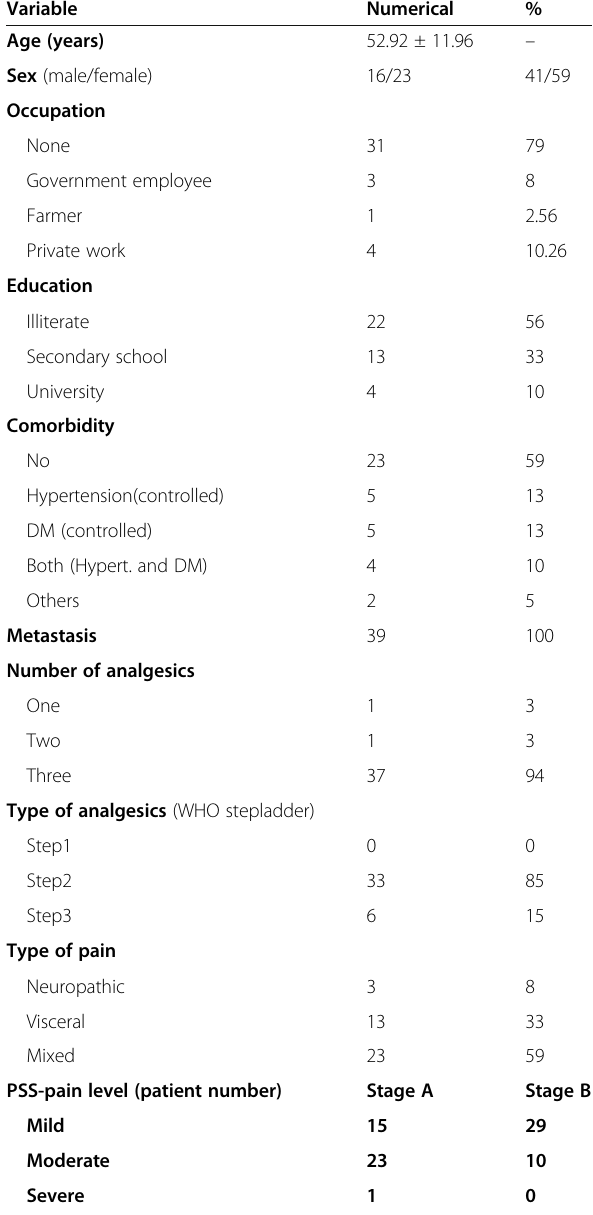
Table 1 Patients demographics and cancer-cancer treatment